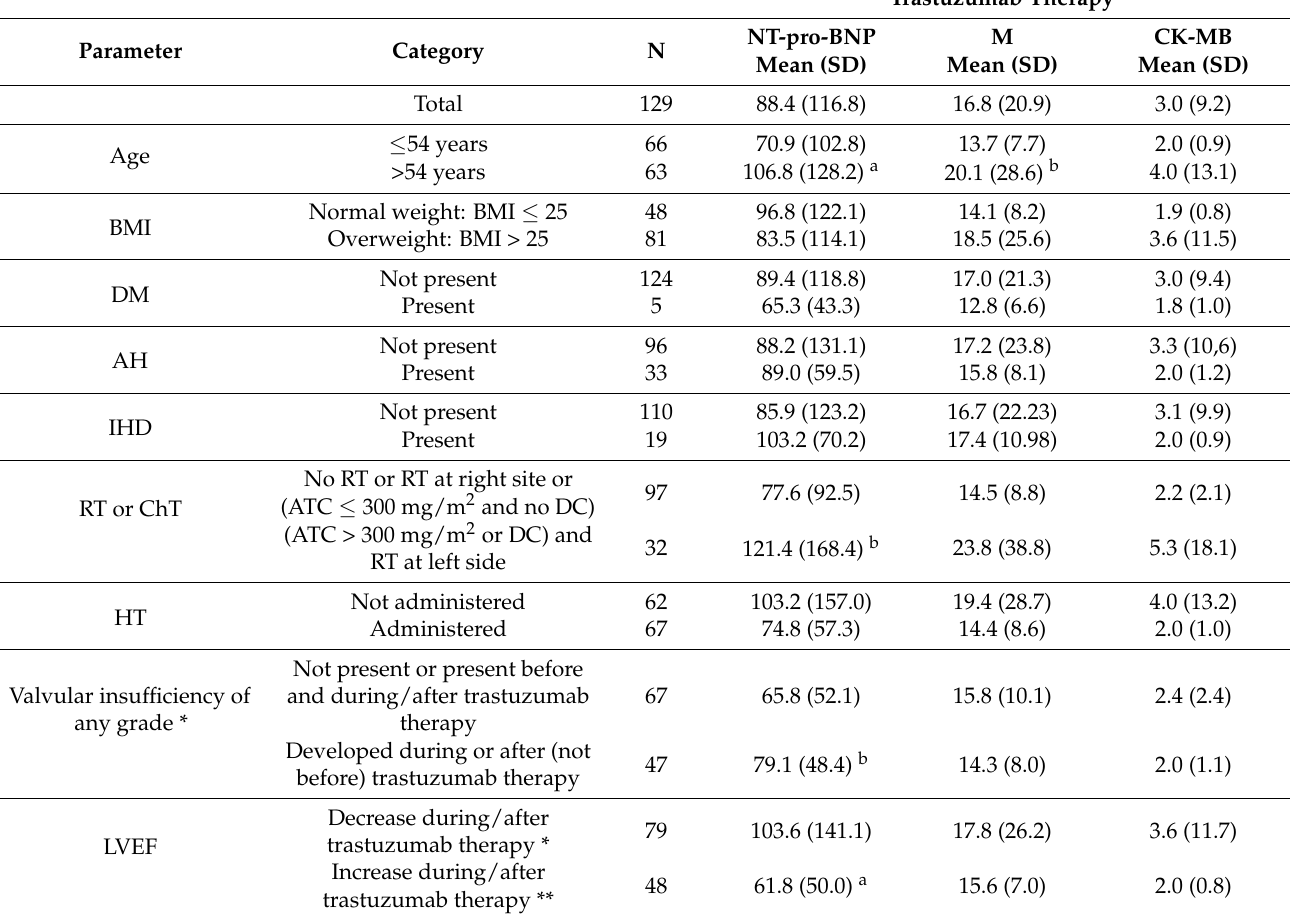
Table 4. Relationship between chosen clinical parameters and cardiac complications/valvular regur- gitation developed during trastuzumab therapy. Mean Value of 6 Measurements before/during/after Trastuzumab